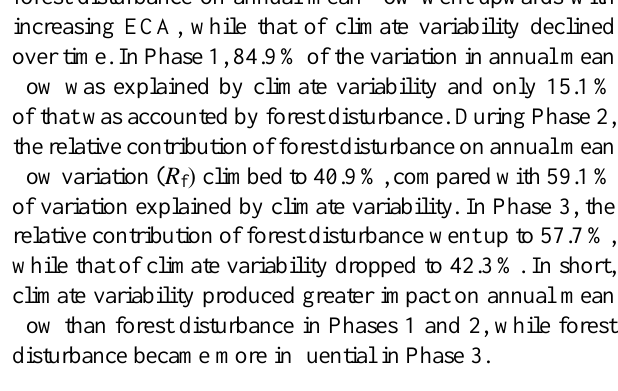
Table 3. Statistical tests of change in the slope of